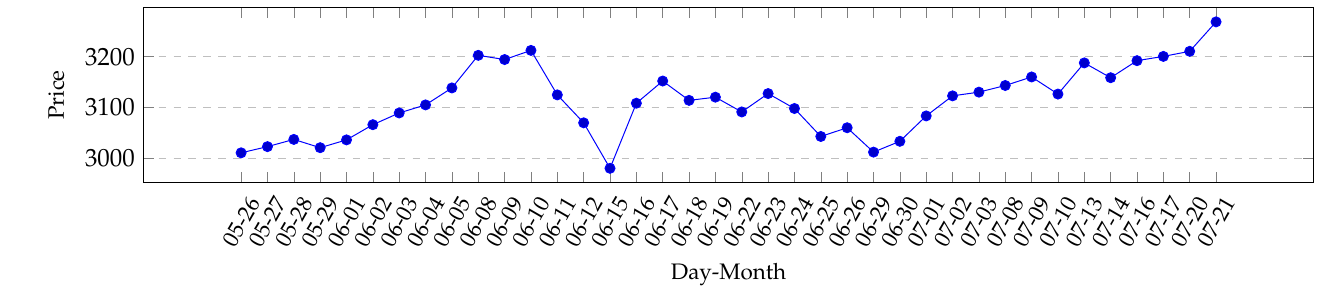
Figure 1. Charted information for US500 market, year